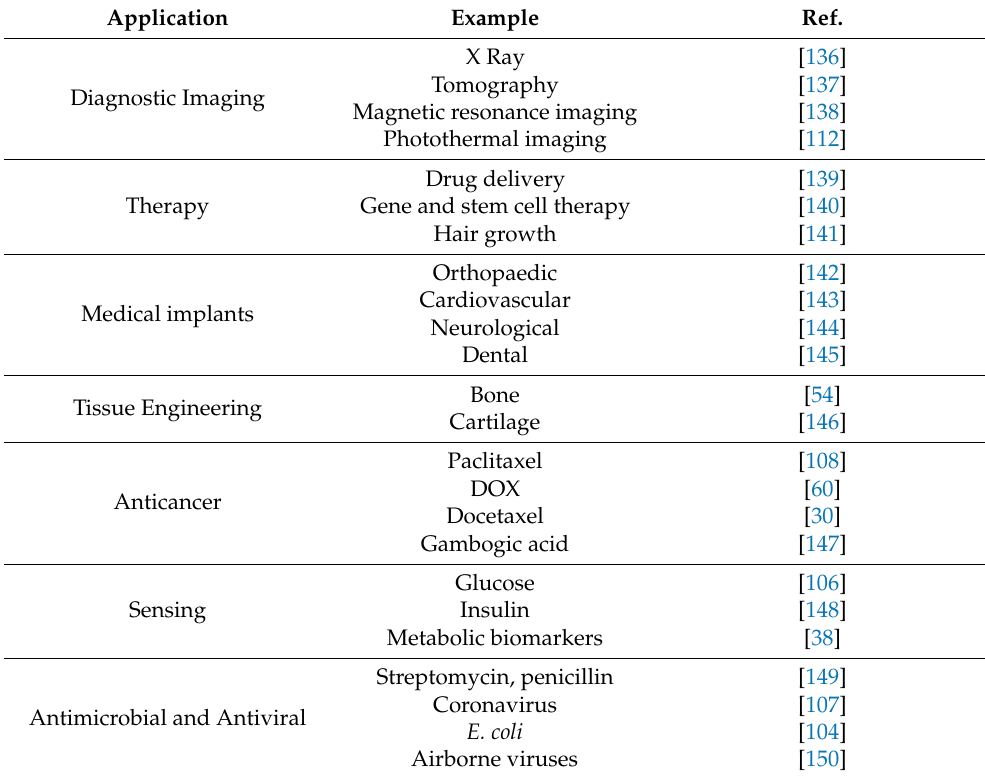
Table 1. Applications of functionalized nanomaterials in